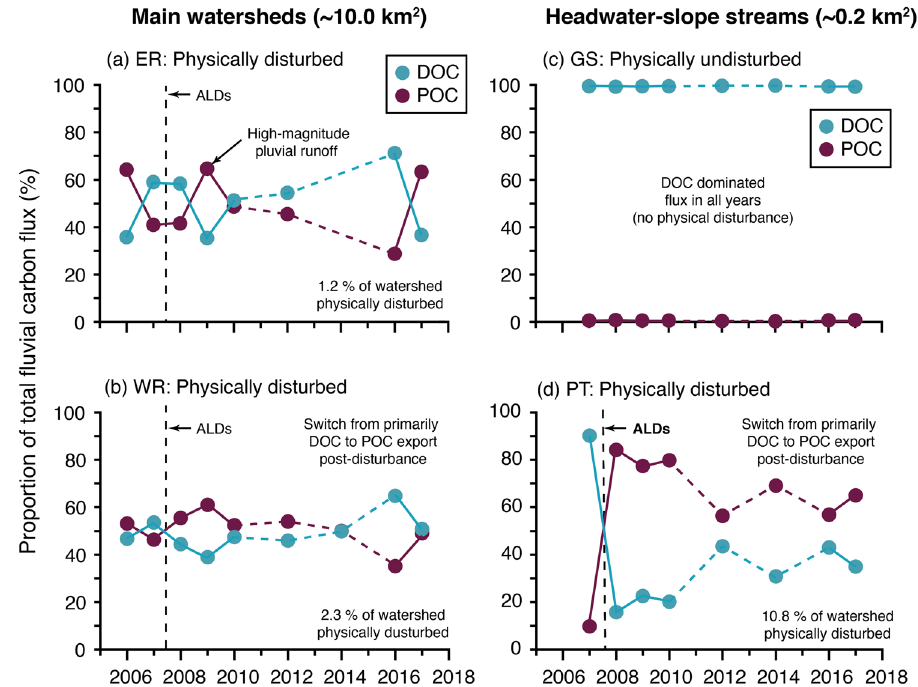
Fig. 5 The impact of permafrost change on watershed carbon export. The impact of localized active layer detachments (ALDs; geomorphological disturbance) on the relative contributions (%) of DOC and POC to the total annual fl uvial C fl ux (2006-2017) in: ( a ) East river (ER; 1.2 % of watershed area disturbed); ( b ) West river (WR; 2.7% of watershed area disturbed); ( c ) Goose stream (GS; no geomorphological disturbance); ( d ) Ptarmigan stream (PT; 10.8% of watershed area disturbed). In geomorphologically undisturbed watersheds ( a ), the annual C fl ux is dominated by DOC; increasing mean annual DOC concentrations from these watersheds were likely the result of watershed greening. Thaw-induced geomorphological disturbance of terrestrial surfaces (a – b,d) decreased annual DOC concentrations at all watershed scales and led to a fundamental shift in the primary form of C export from a DOC- to a POC-dominated fl ux ( p < 0.05), with the magnitude and persistence of impact increasing with areal extent of watershed